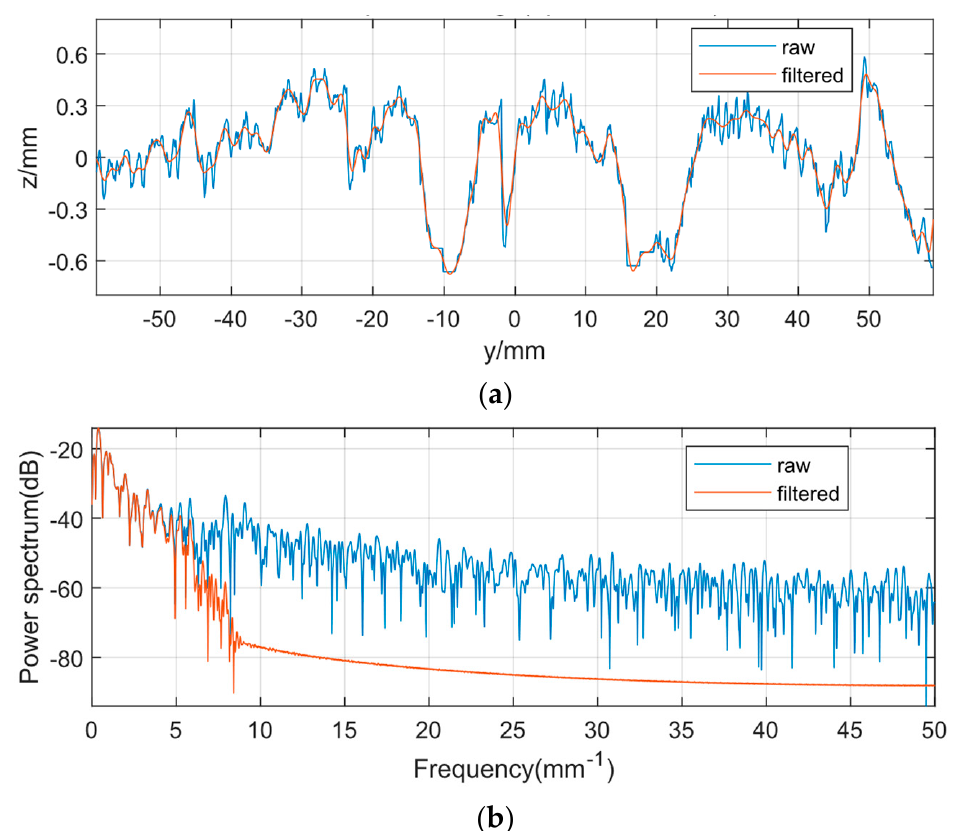
Figure 7. Macro-texture filtering results. ( a ) Low-pass filtering of texture (Fpass = 2 mm − 1 ). ( b ) Power spectrum of low-pass filtered texture.